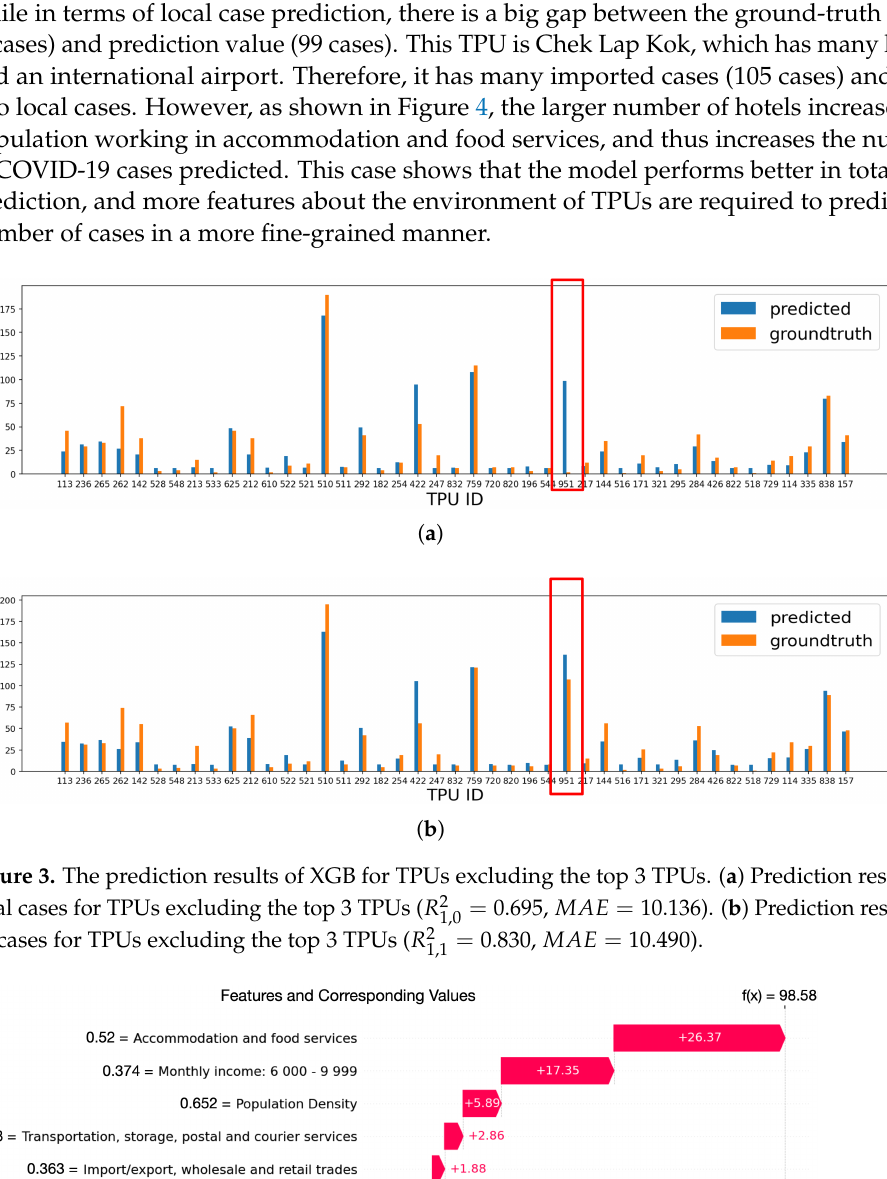
Figure 4. The influence of population features of TPU with ID 951 on